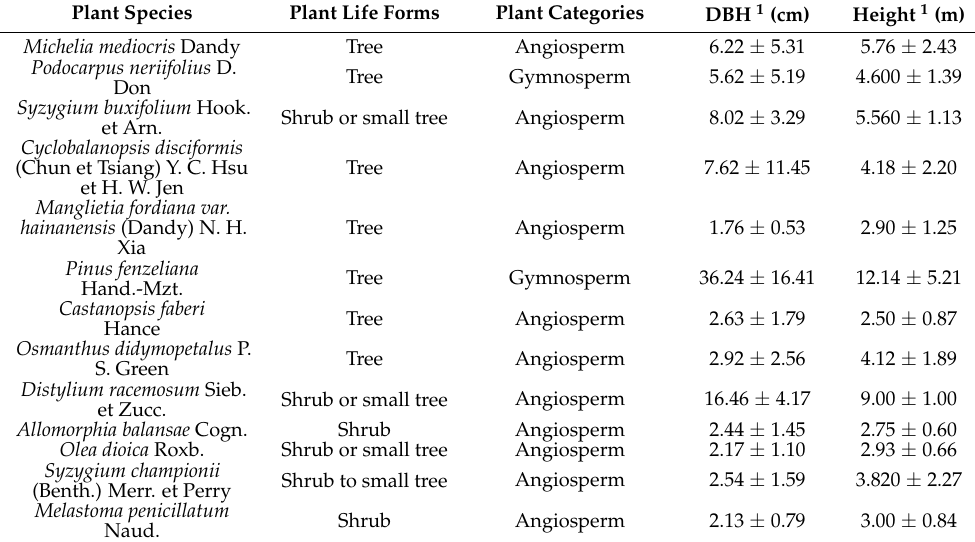
Table 1. Plant life forms, categories, stem diameter and height of plant species involved in the study.